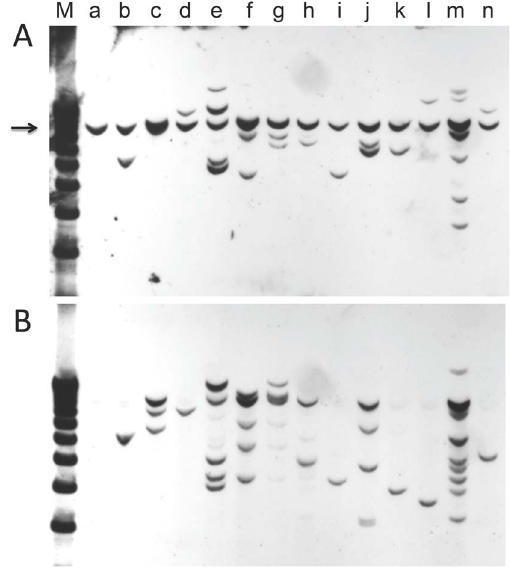
Figure 5. Integration patterns of the myc and ras genes in cell lines derived from tumors induced by circular pMSV-T24-H- ras / MSV-c- myc . DNA was isolated from tumor cell lines, digested with Bgl II, an enzyme that cuts the plasmid once, transferred to a membrane, and probed with a myc probe ( A ) or a ras probe ( B ). Lane a is mouse NIH/3T3 DNA; lanes b to q represent different tumor cell lines. Lanes e, f, and g are from three tumors found on a single mouse. Marker lanes are M (1 kb ladder) and l (Lambda DNA digested with Hind III). The position of the endogenous mouse c- myc gene is indicated by the arrow.